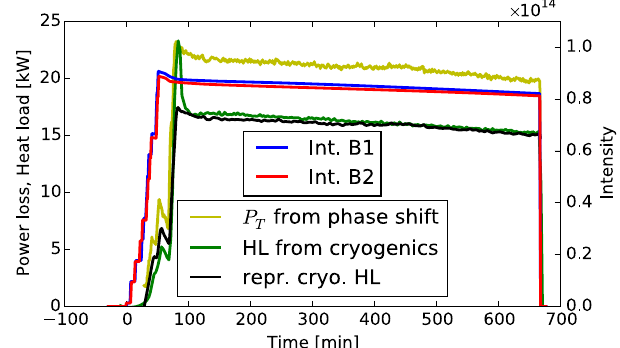
FIG. 13. Total beam power loss ( P T ) found from the phase shift (yellow line) and the heat load (HL) measured by the cryogenic system (green line) [13,14], for a fill with 25 ns beams accelerated to 4 TeV (Fill 3429, 13-12-2012). An estimation of the cryogenic heat load (black line) was made from the phase shift measure- ments as described in the text (a scale factor of 0.76 was used to fit the part at 4